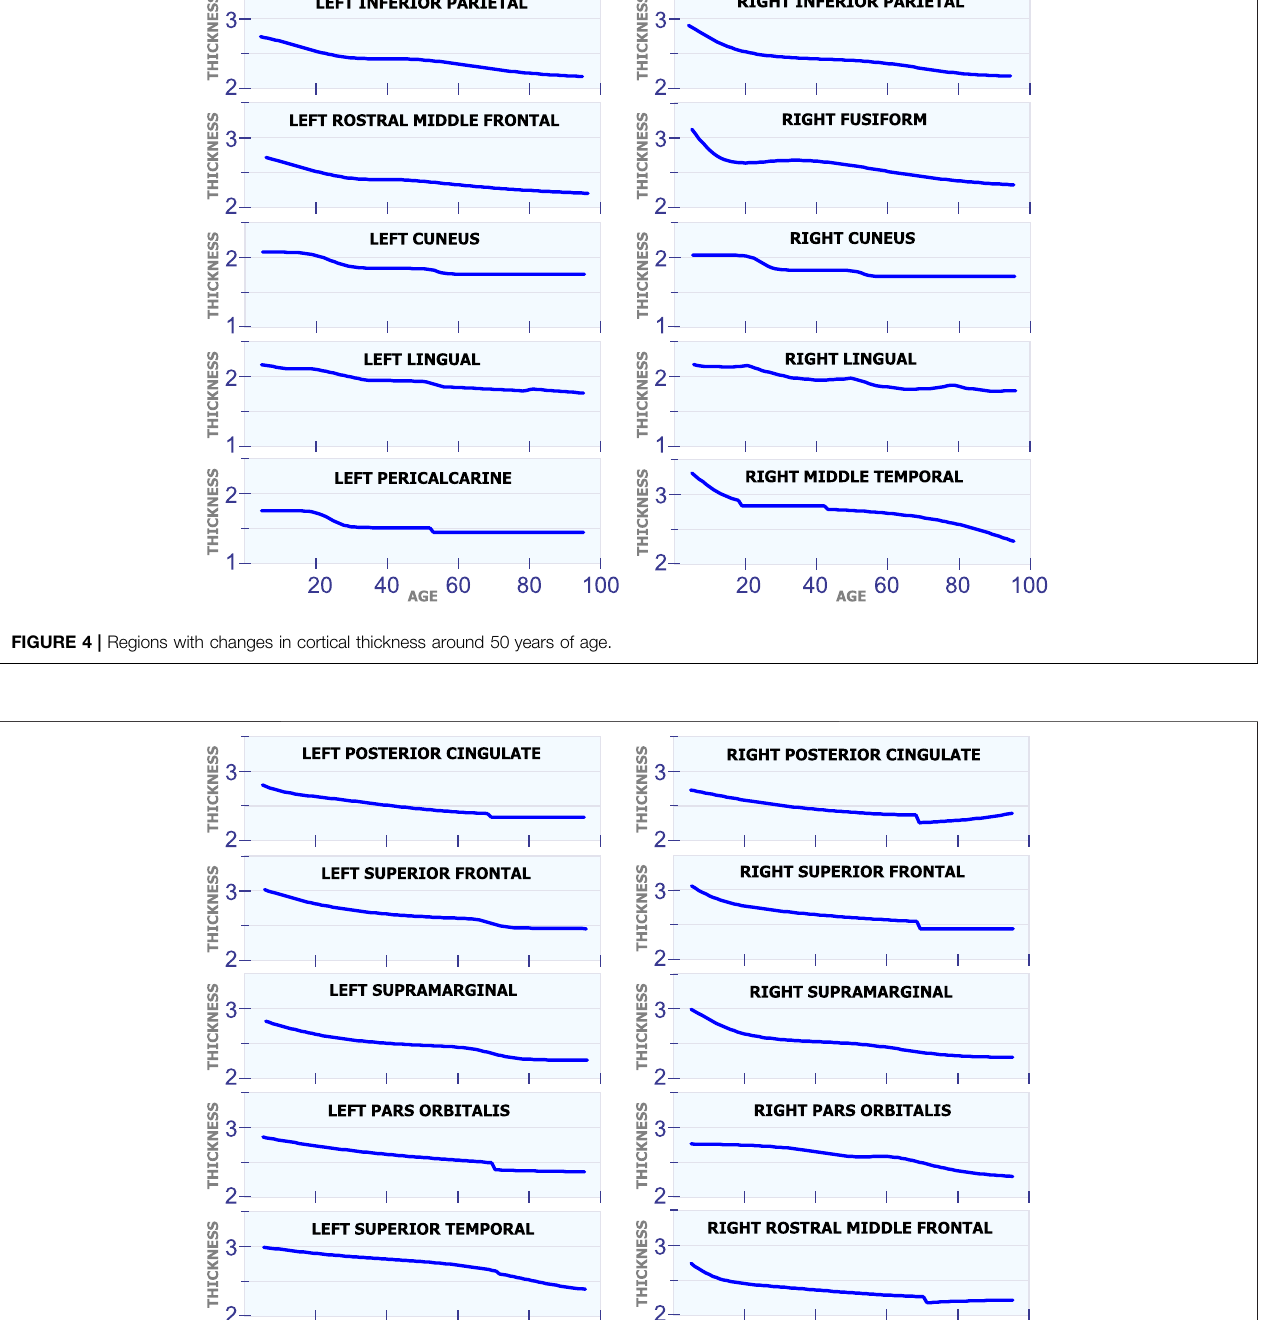
same sense, an unexpected reduction around age 38 is present in the right lateral orbitofrontal and the right medial orbitofrontral. The last row in Figure 3 shows the behavior of the cortical thickness in the left middle